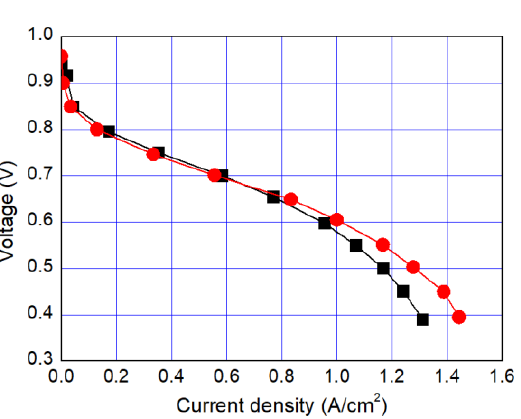
Figure 8. I–V polarization curves of the membrane-electrode assemblies using Nafion 212 ( black ) and the composite membrane ( red ) using the GA / #3_30-treated porous